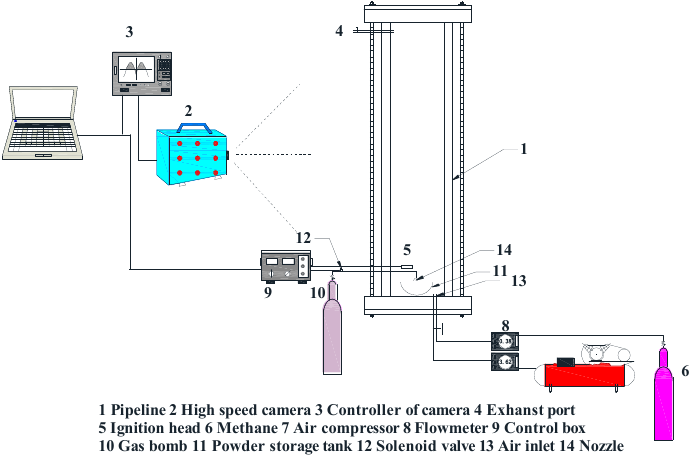
Figure 2. The illustration of the pipeline explosion system.